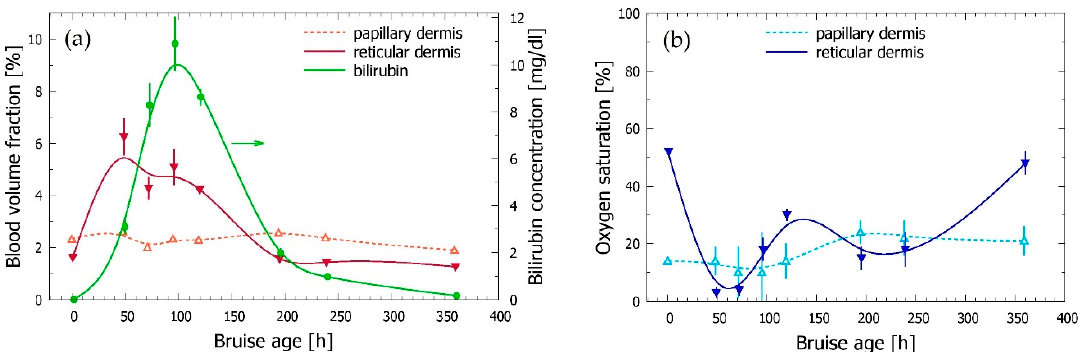
Figure 4. Time evolutions of the bruise model parameters as assessed from analyses of the data obtained from subject a at different times after injury: ( a ) Volume fractions of blood in the papillary and reticular dermis, and concentration of bilirubin when confined to the dermal layers; and ( b ) oxygenation levels of blood in both dermal layers. (The curves have no theoretical basis and serve only as a guide to the eye).